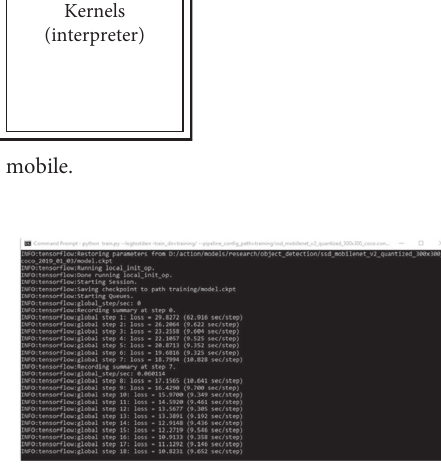
Figure 14: Simulation scenario starts for 20 steps.